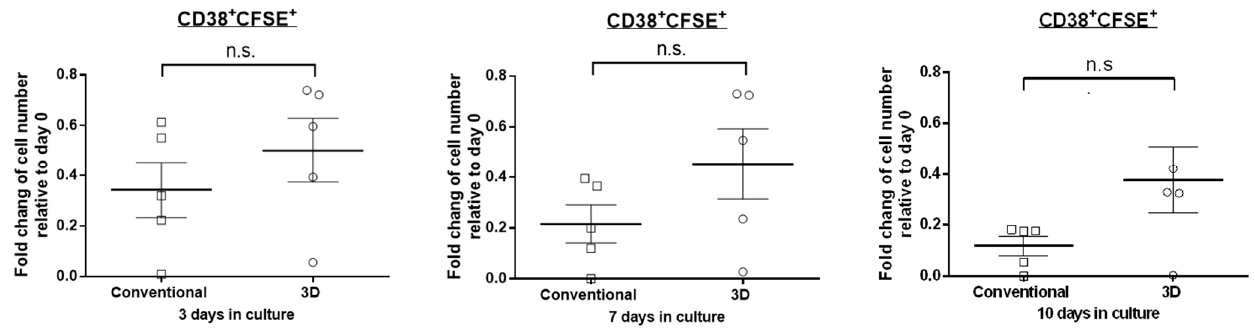
Figure 2. PM cells in 3D did not proliferate more rapidly than those in conventional culture. Fold change of viable CD38 + CFSE+ cell number from 5 MM patients in conventional or 3D culture on day 3, 7 and 10 relative to day 0. The mean values were indicated with error bars representing standard error. n.s. not significant, paired Student’s t -test.